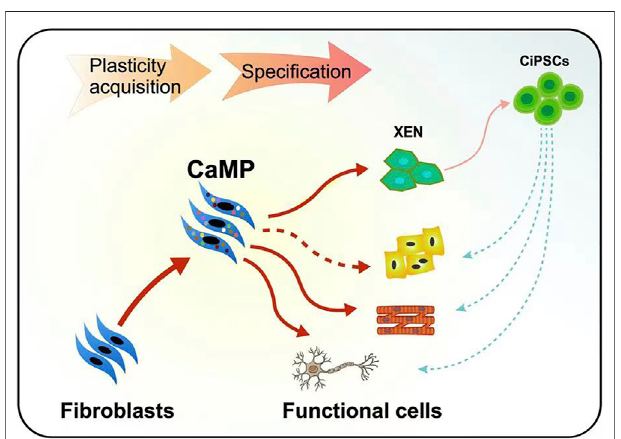
FIGURE 8 | Graphical abstract of the plastic CaMP state amenable to direct lineage reprogramming.